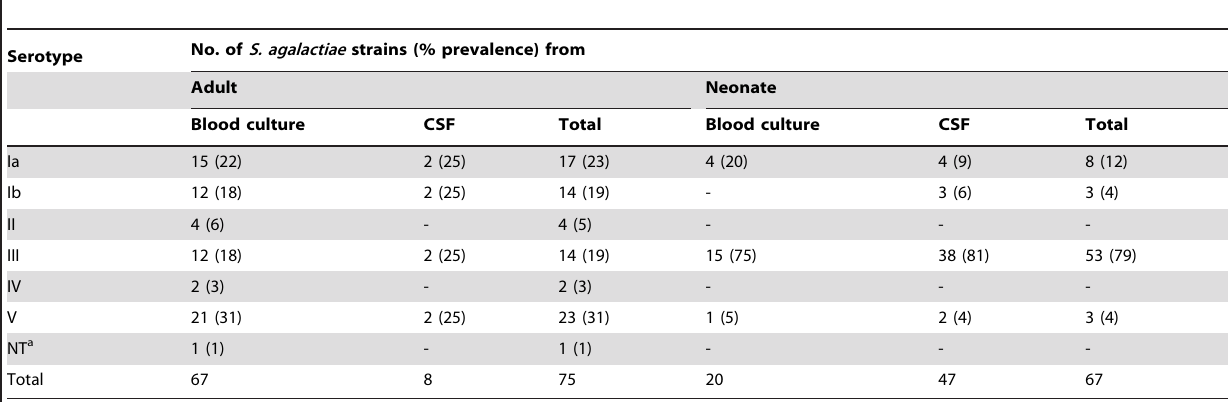
Table 2. Serotypes of S. agalactiae isolates from blood cultures and CSF from adults and neonates.